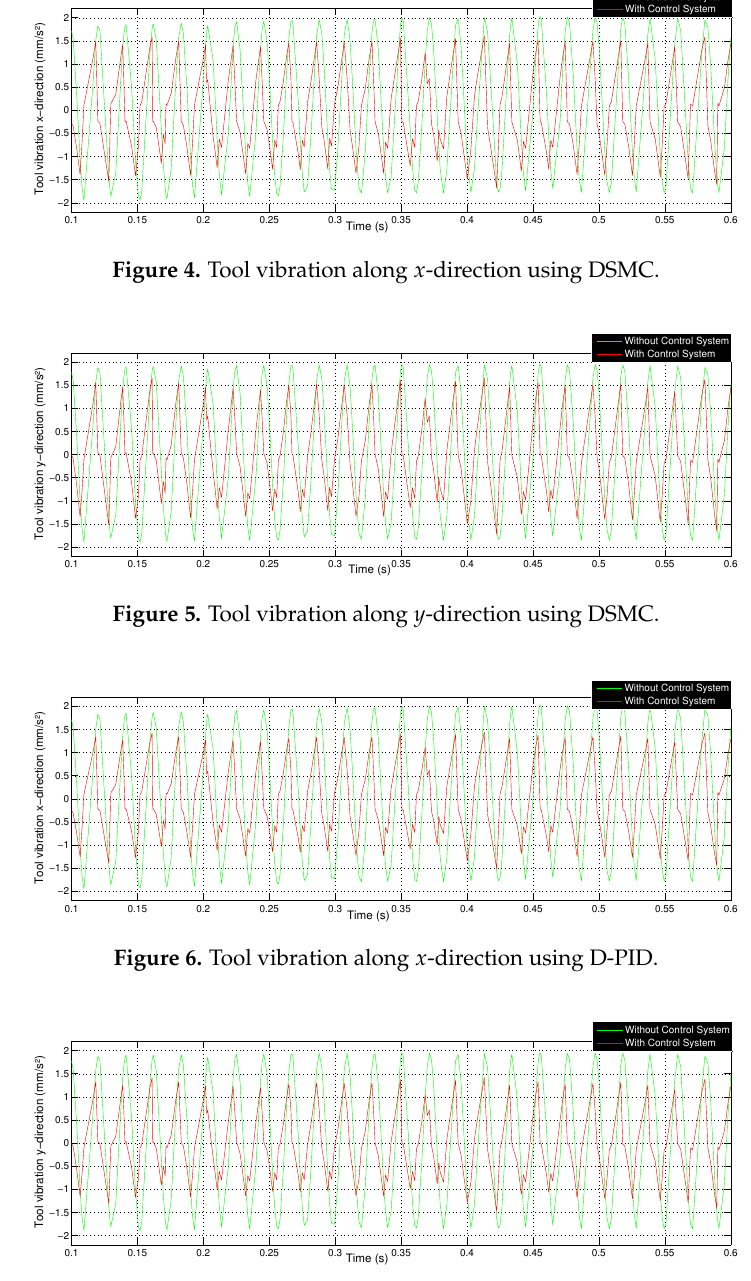
Figure 7. Tool vibration along y -direction using D-PID.